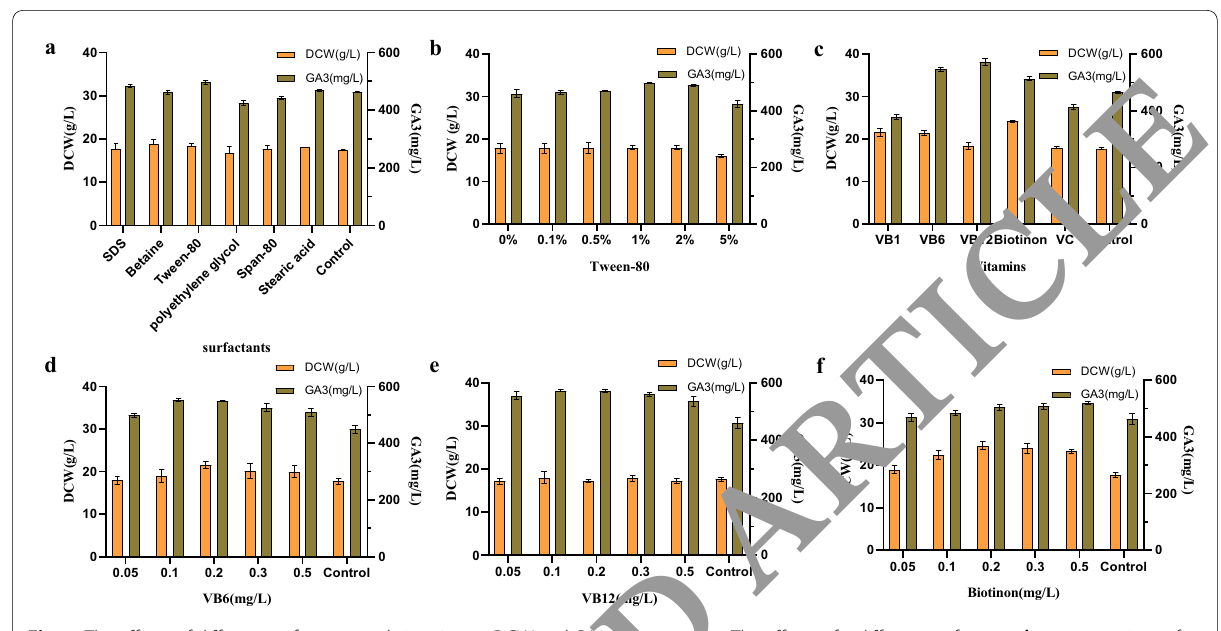
Fig. 5 The effects of different surfactants and vitamins on DCW and GA3 concentration. The effects of a different surfactants, b concentrations of tween‑80, c different vitamins, d concentrations of VB6, e concentrations of VB12, f concentrations of biotin on DCW and GA3